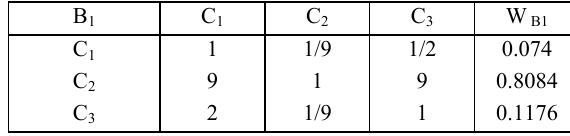
Table 2. The pairwise comparison matrix C 1-3 –B 1